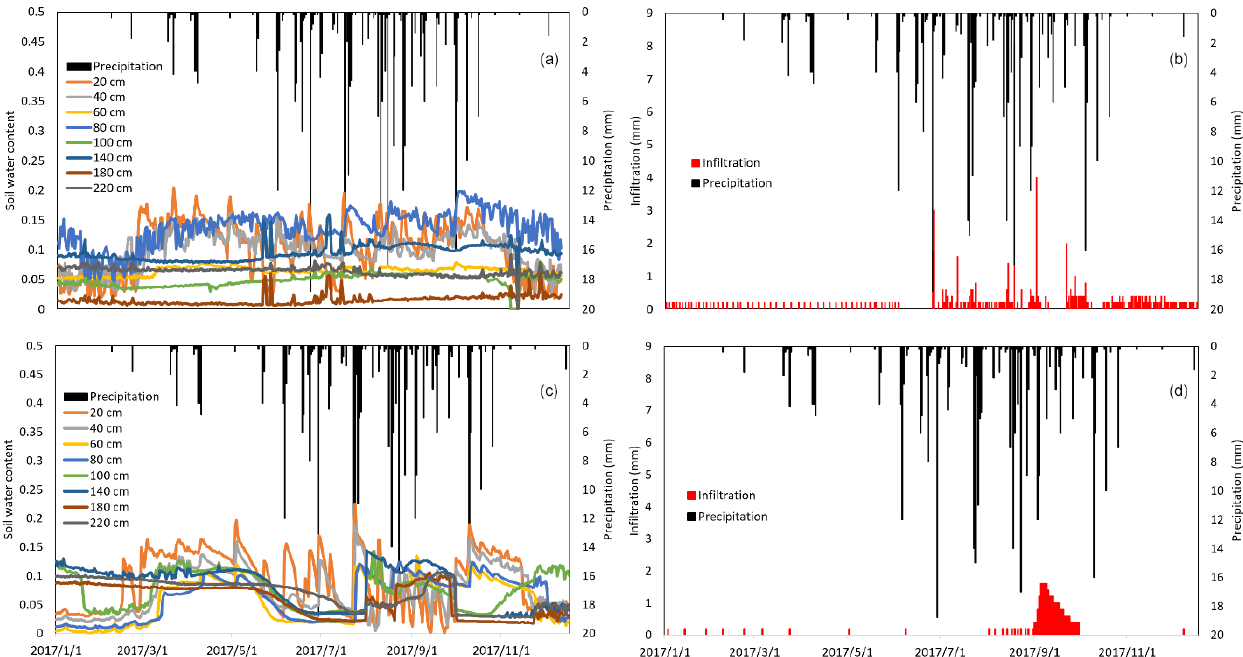
Figure 6. Effects of precipitation on soil moisture (a) and DSR (b) in the bare sandy land plot; effects of rainfall on soil moisture (c) and DSR (d) on the ASK plot, 2017.